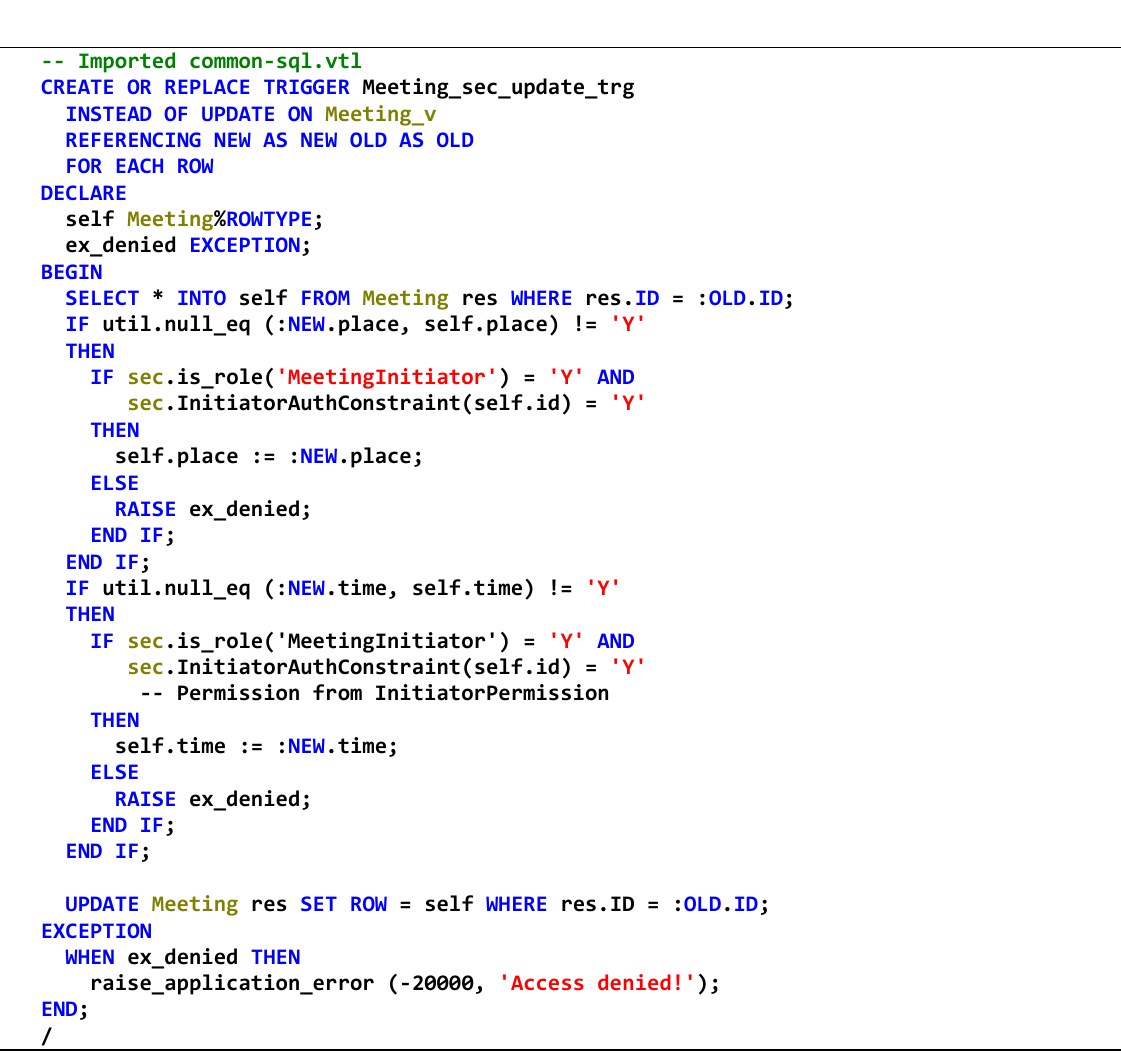
Figure 15. Transformed Update authorisation